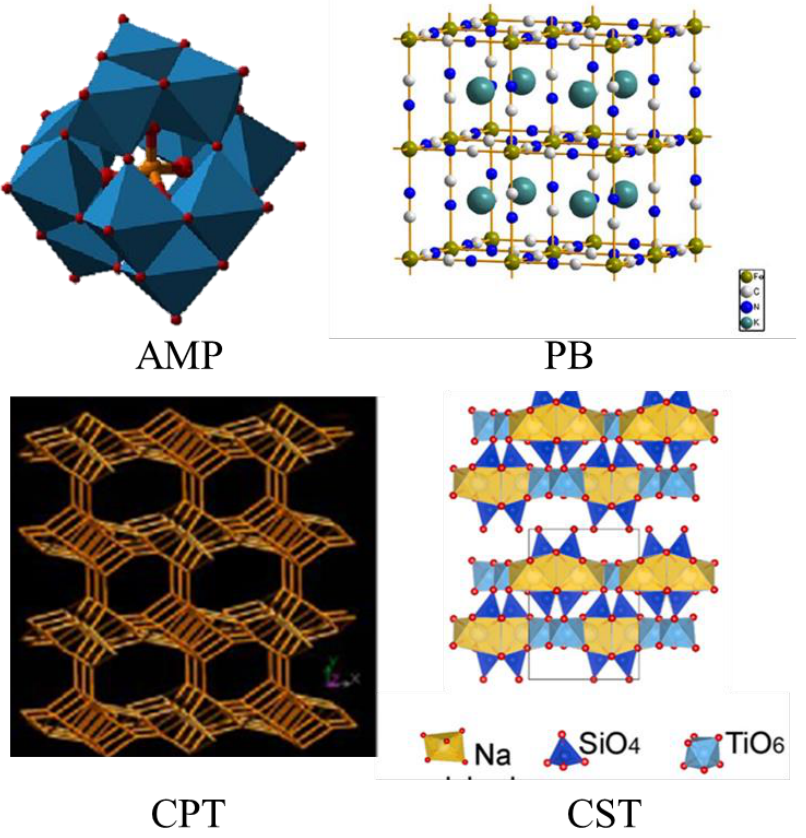
Figure 7. Schematic diagram of adsorbents structure. The adsorption of cesium by PB is controlled by three mechanisms [26]: ion exchange between potassium ion and cesium ion, surface vacancy adsorption for cesium ion, and chemical adsorption at the hydrophilic lattice defect sites, in which the protons are displaced from the coordination water. The chabazite possesses an eight-element ring channel structure with a pore size of 3.8 Å and a pore volume of approximately 0.42 cm 3 g − 1